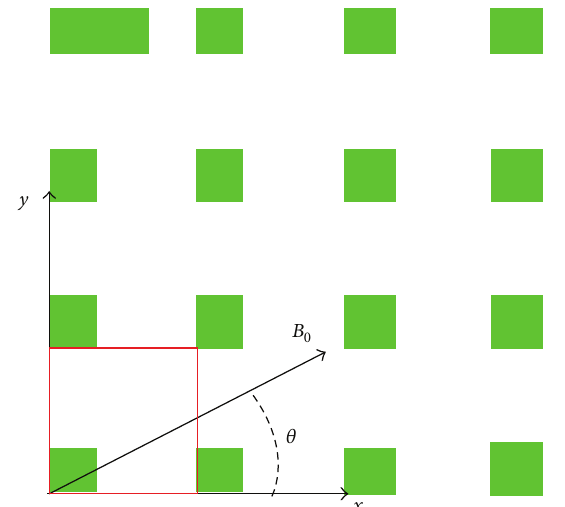
Figure 1: Primitive cell of the 2D magnonic crystal used for calculations. The angle 𝜃 is the direction at which the external magnetic field 𝐵 0 is applied. Distance between the small squares is = 15 nm. This cell is unitary only for the secondary sublattice 𝑎 1 ( 𝑎 2 = 4𝑎 1 ). The red line square is the ideal unitary primitive cell of the primary sublattice (which was however not directly used in the